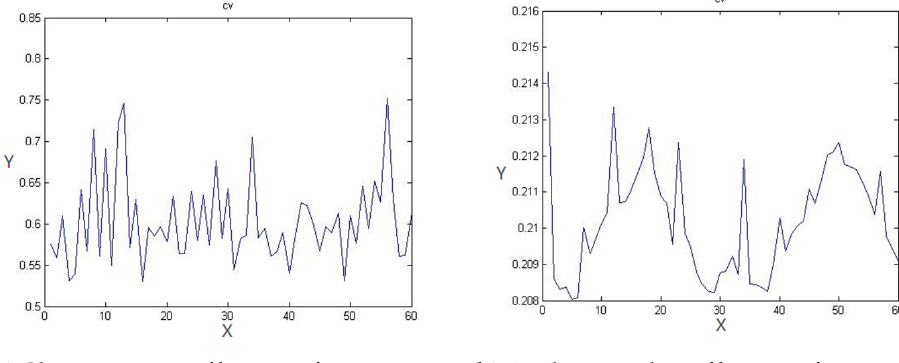
Figure 10. Coefficient of variation. Figure 10. Coe ffi cient of